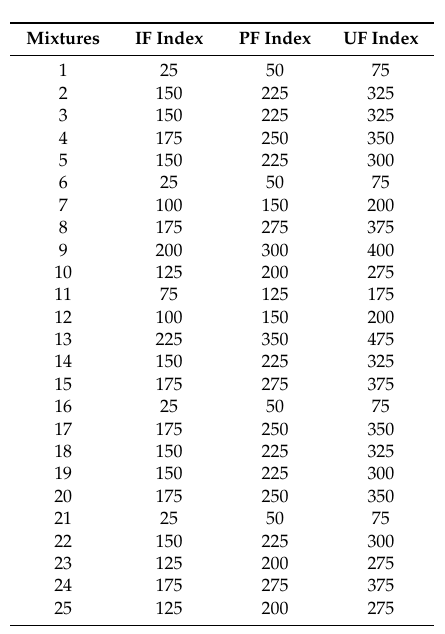
Table 4. The frost-induced failure indices for ECC